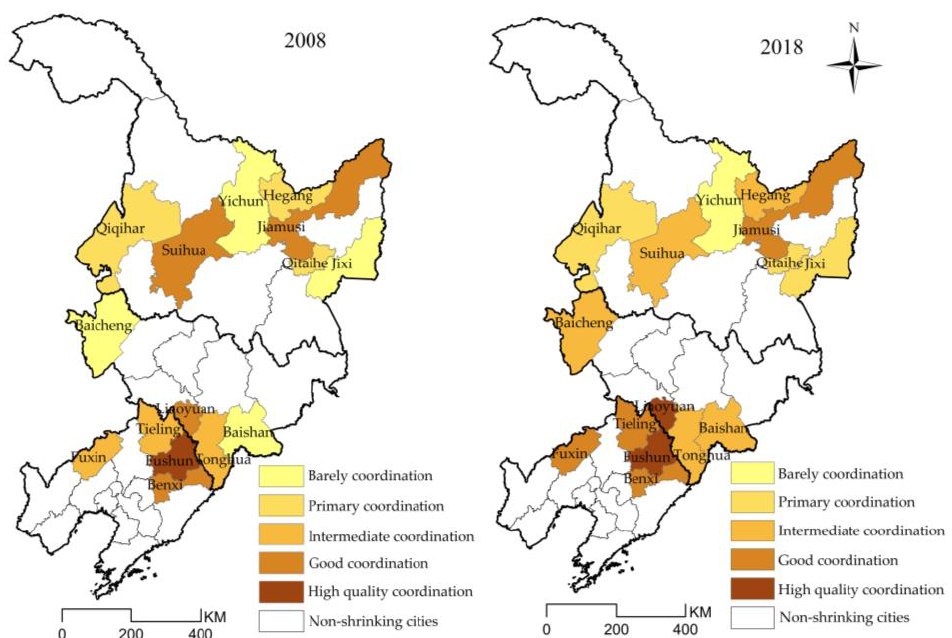
Figure 6. The spatial pattern of the coupling coordination degree of shrinking cities in 2008 and 2018. (Source: Authors).